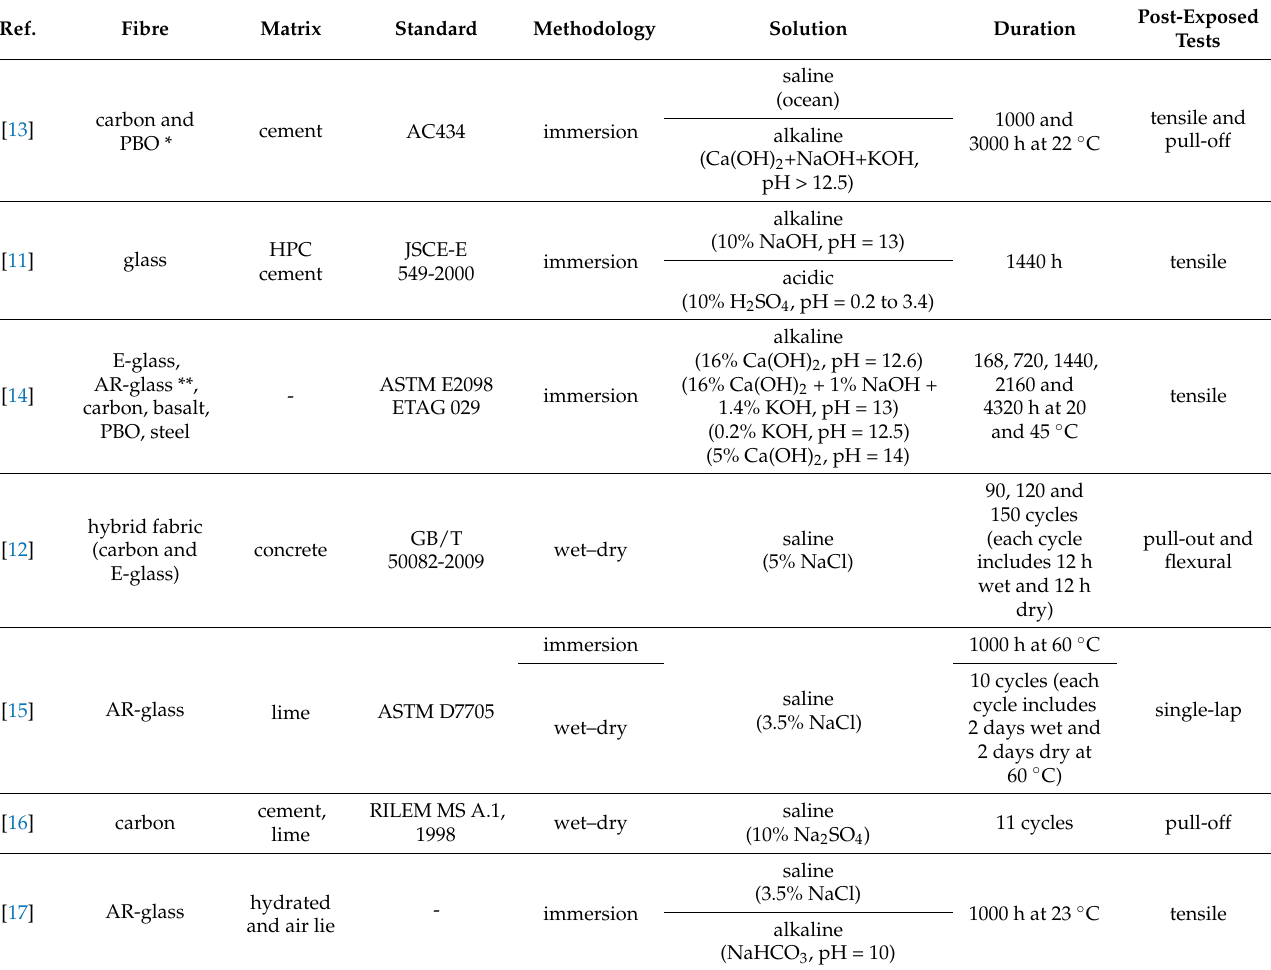
Table 1. Summary of literature on chemical